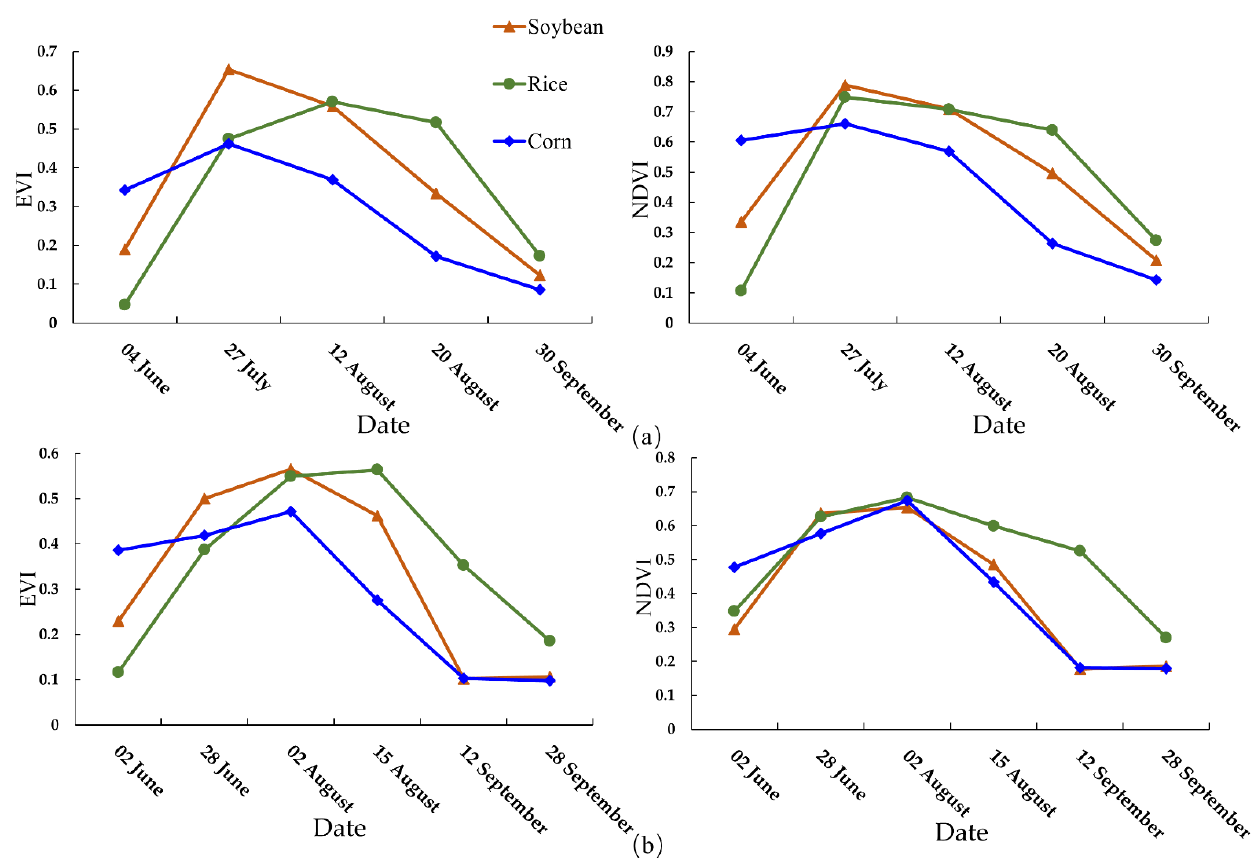
Figure 6. Normalized difference vegetation index (NDVI), enhanced vegetation index (EVI) time series of rice, corn, and soybean-based on GF-6 ( a ) and GF-1 ( b ).